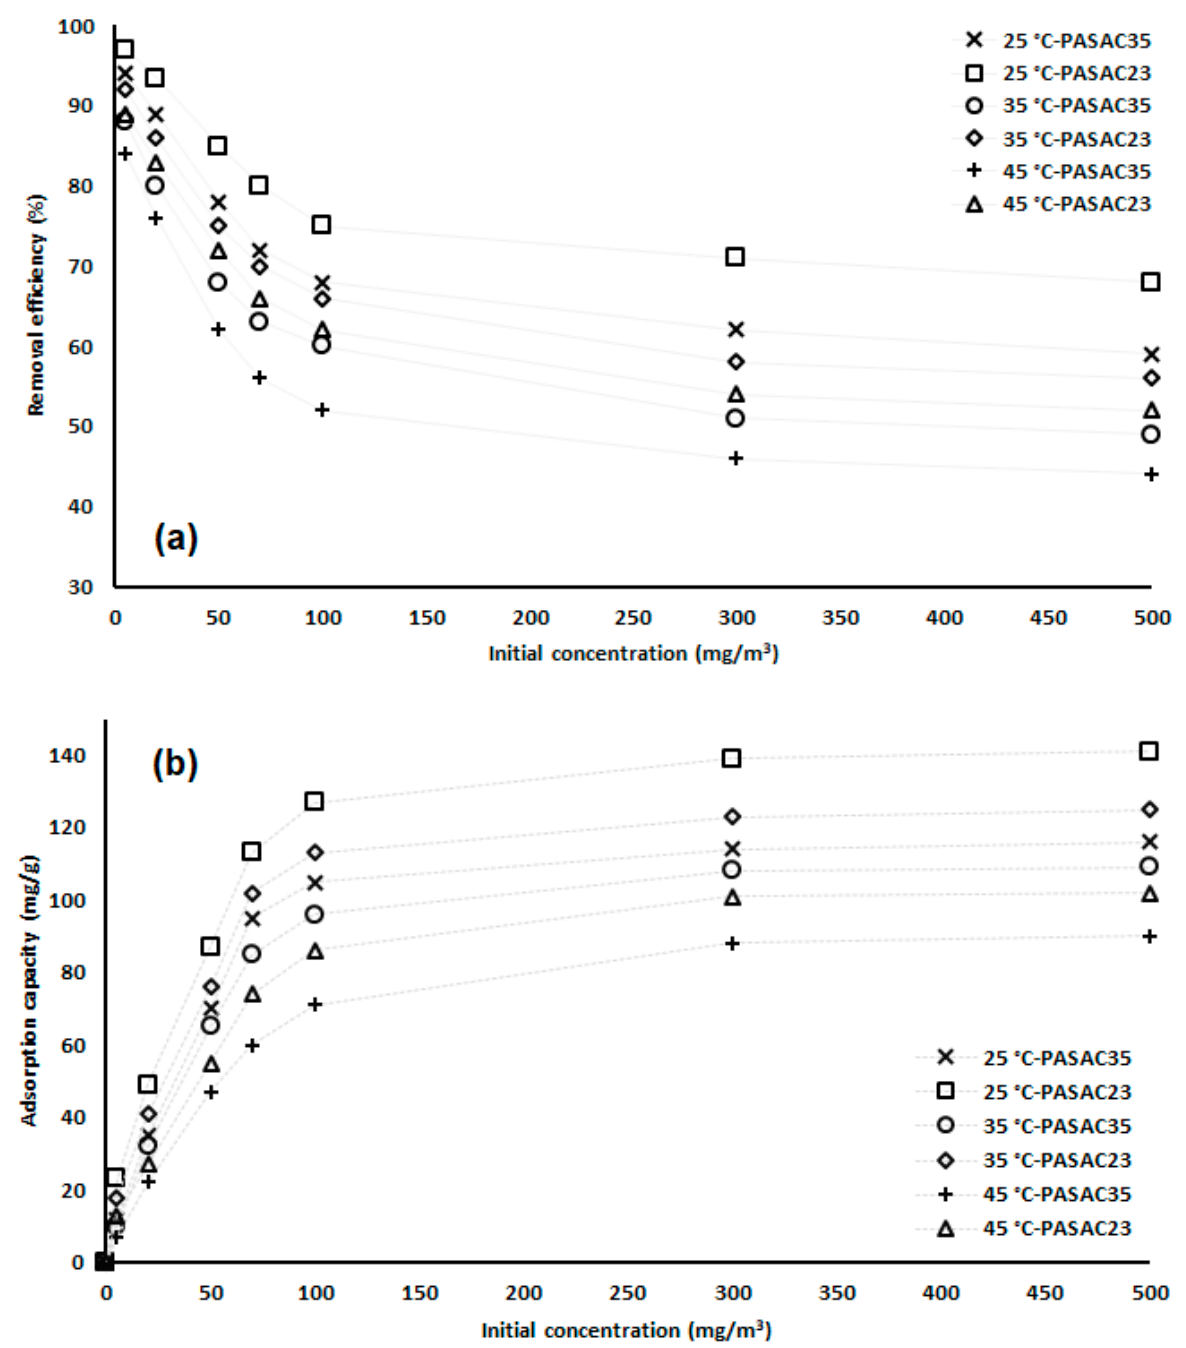
Figure 5. Initial concentration and its effect on adsorption ( a ): removal efficiency and ( b ): adsorption capacity.